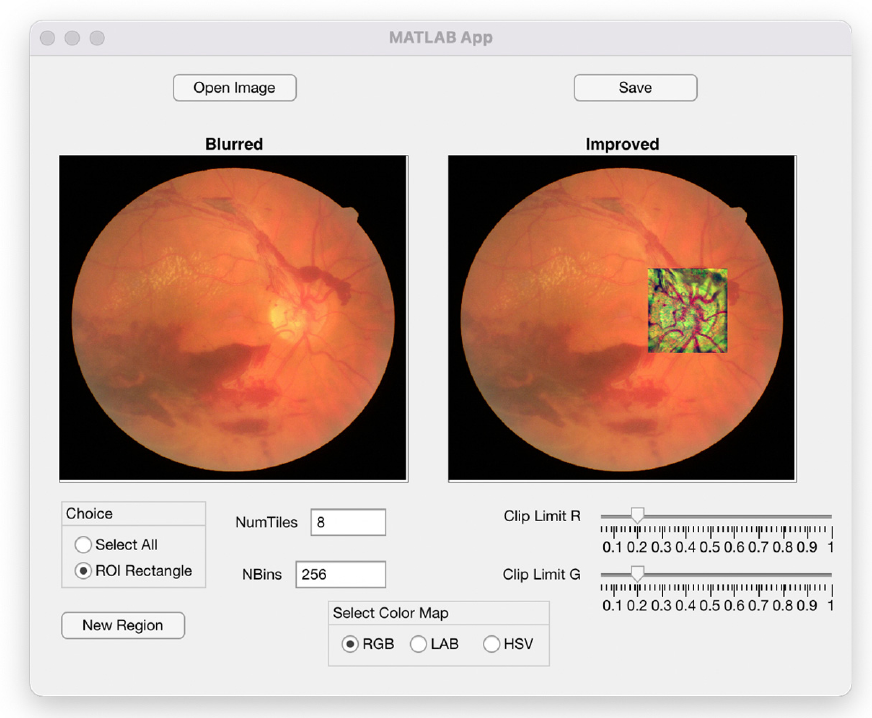
Figure 9. Image of the menu used for running the algorithm.